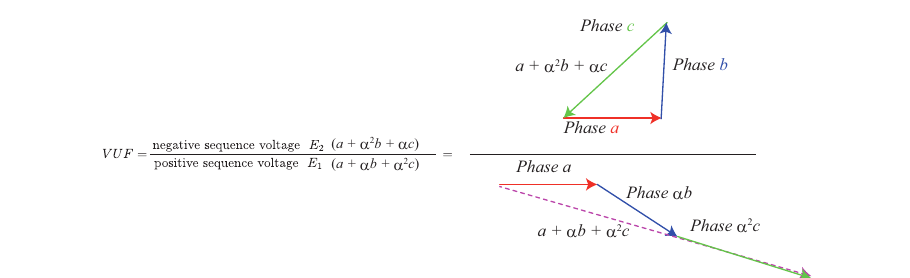
Figure 6. An unbalanced condition but VUF 1 = 0.